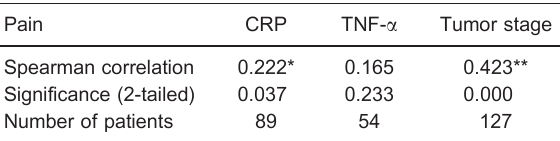
Table 2. Relationship between pain, CRP and TNF- a in patients with head and neck cancer.